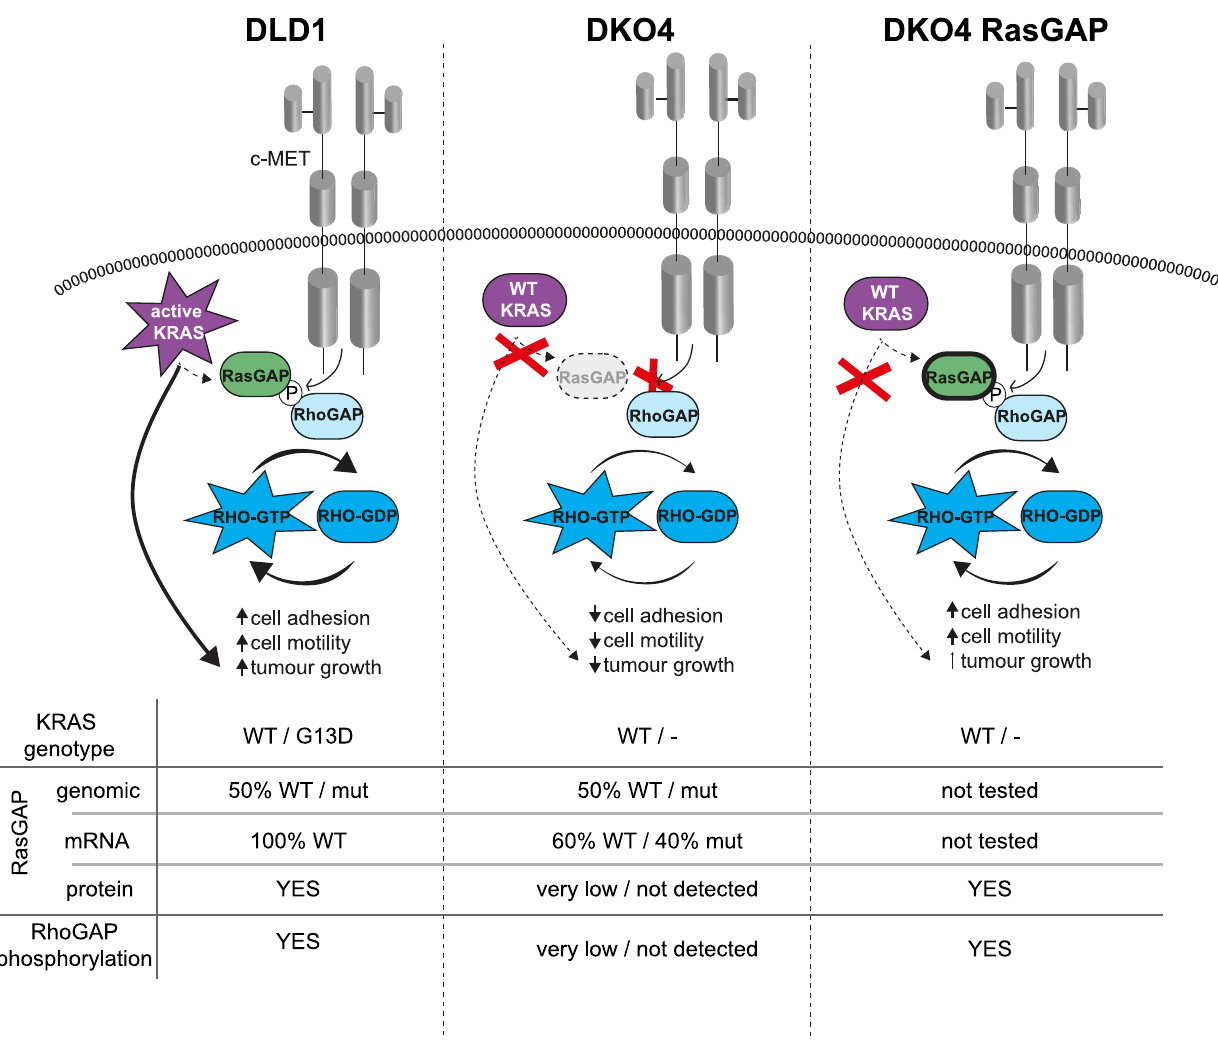
Figure 6. Summary of findings and proposed mechanism. In DLD1 cells, active KRAS stabilizes RasGAP expression, which in turn binds to and stabilizes RhoGAP phosphorylation. This complex then activates Rho pathway activation, either by sequestration of RhoGAP away from Rho, or by increasing Rho turnover. In DKO4 cells, RasGAP is not expressed, due in part to a truncating mutation and in part to lack of expression downstream of active KRAS. In this situation, RhoGAP is not phosphorylated, and so Rho pathway phenotypes are inactive. When RasGAP is overexpressed in DKO4, RhoGAP is once again phosphorylated and Rho pathway is active- however, lack of stabilization and/or contributing signaling pathways from active RAS means that tumorigenicity does not attain the same level as DLD1. The bottom of the figure summarizes the main characteristics of RhoGAP and RasGAP in these cell lines.